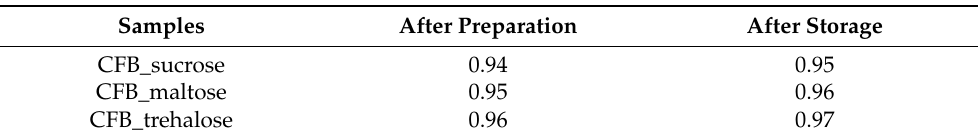
Table 4. Water activity of citrus fiber-blackberry cream fillings after preparation and after storage at room temperature for three